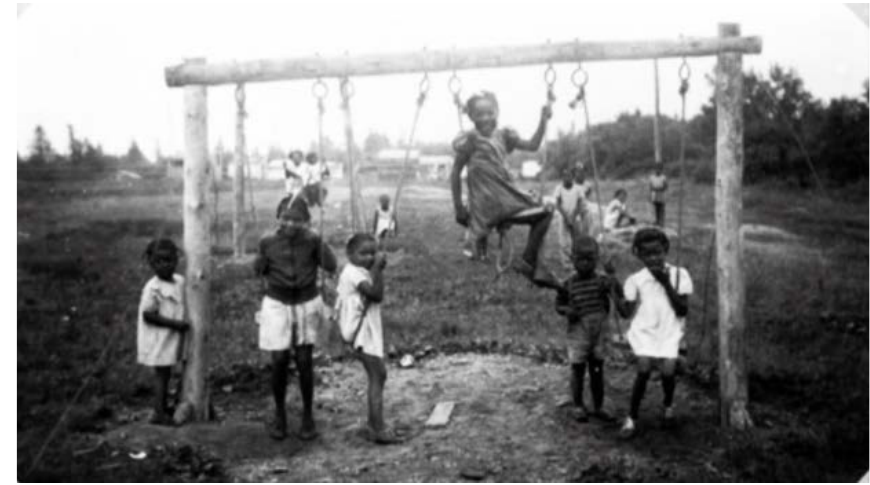
Figure 8. Community activity on parking lot asphalt. Photo from Preston Facebook Page.